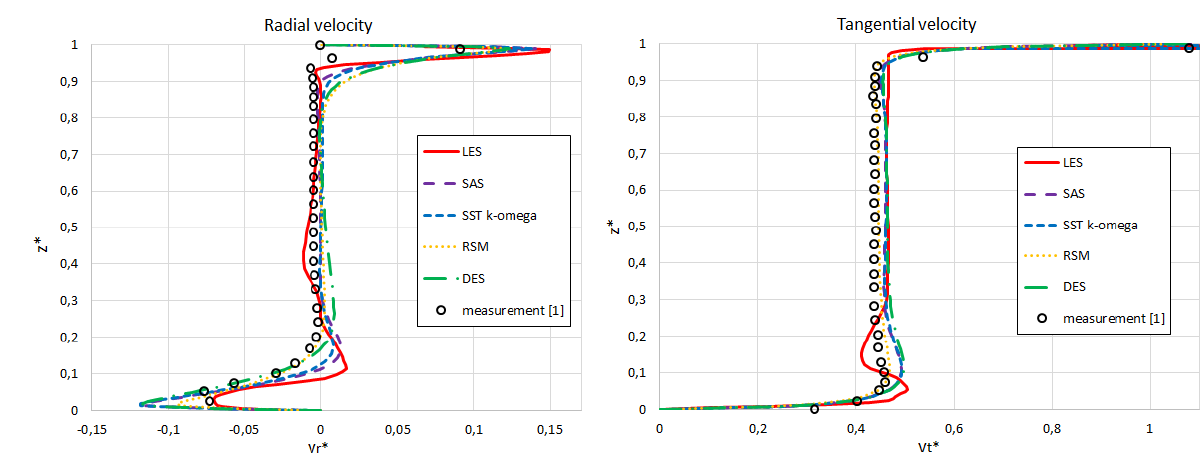
Fig. 7. Radial and tangential velocity profile obtained by di ff erent turbulence models and by measurement